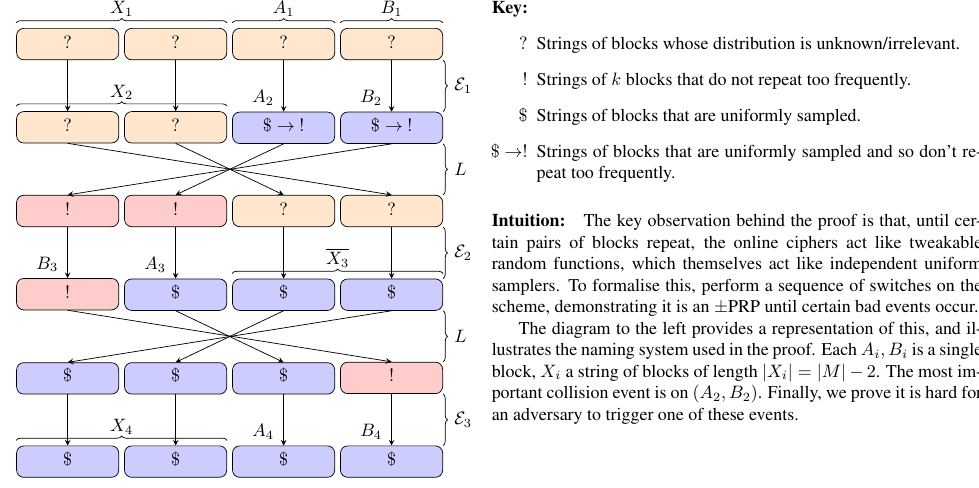
Figure 15: Intuition behind the ± prp security of Π rev